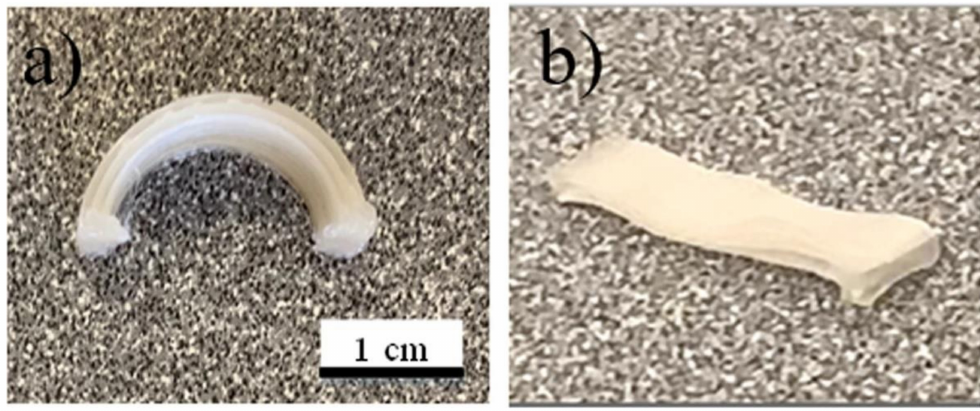
Figure 21. ( a ) Four-dimensional (4D)-printed PLA arc and ( b ) flattened temporary shape (Reproduced with permission from Reference [173], copyright 2019,